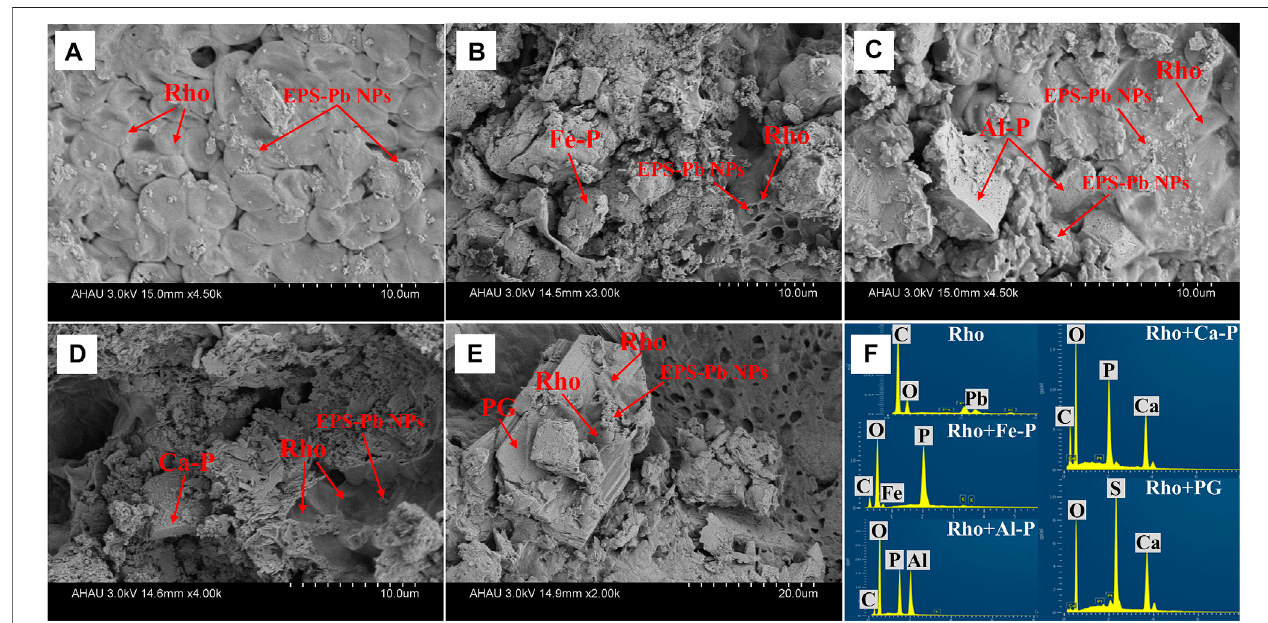
FIGURE6 | SEM image data inRho (A) , Rho + Fe-P (B) , Rho +Al-P (C) , Rho + Ca-P (D) , and Rho +PG (E) treatments after 6 days ofincubation. The EDSresults (F) ineachtreatmentafter6 daysofincubation.TheRhoandEPS-Pbcanbeobservedineachtreatment.Fe-P:ferricphosphate(FePO 4 );Al-P:aluminumphosphate(Al- P, AlPO 4 ); Ca-P: tricalcium phosphate (Ca 3 (PO 4 ) 2